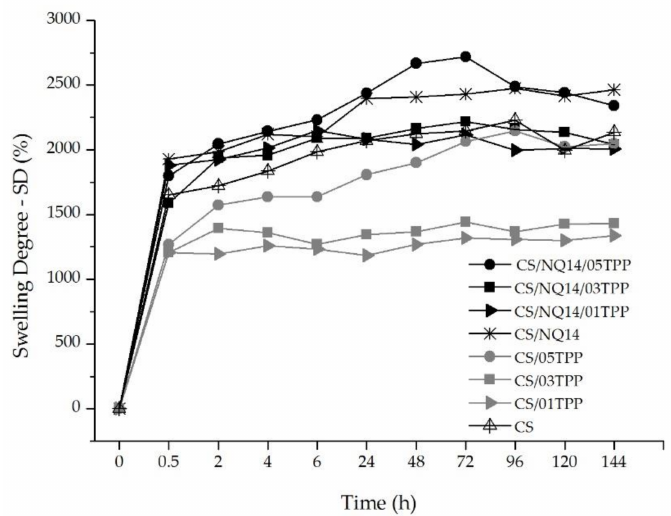
Figure 7. Swelling degree of the non-crosslinked and ionically crosslinked chitosan membranes before and after NQ14 loading with the immersing